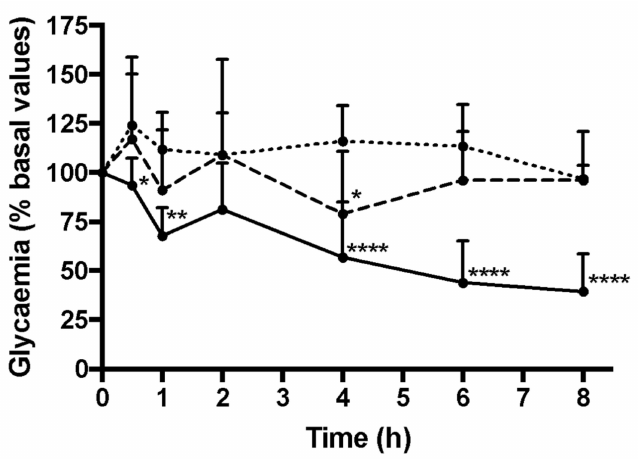
Figure 9. Glycaemia levels of diabetic rats treated with commercialized insulin ( ... , n = 6, 50 IU / kg), empty (—, n = 3, equivalent amount) and double-coated insulin-loaded NPs (___, n = 5, 50 IU / Kg), orally administered. The results are presented regarding their mean ± SD (* p < 0.0332; ** p < 0.0021; *** p < 0.0002; **** p <